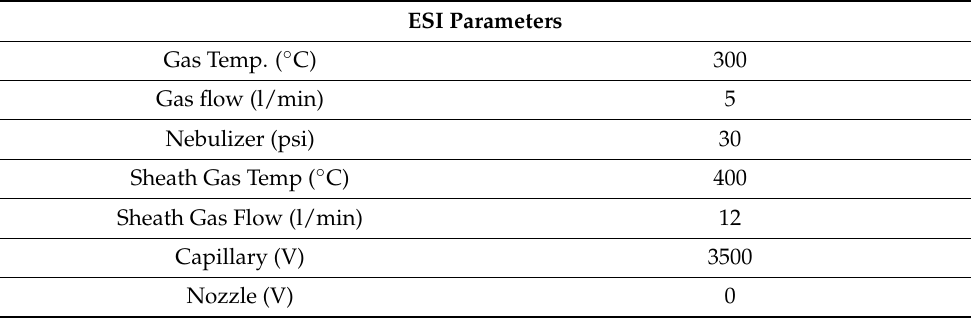
Table 5. Table showing ESI parameters used in sphingolipid analysis by mass